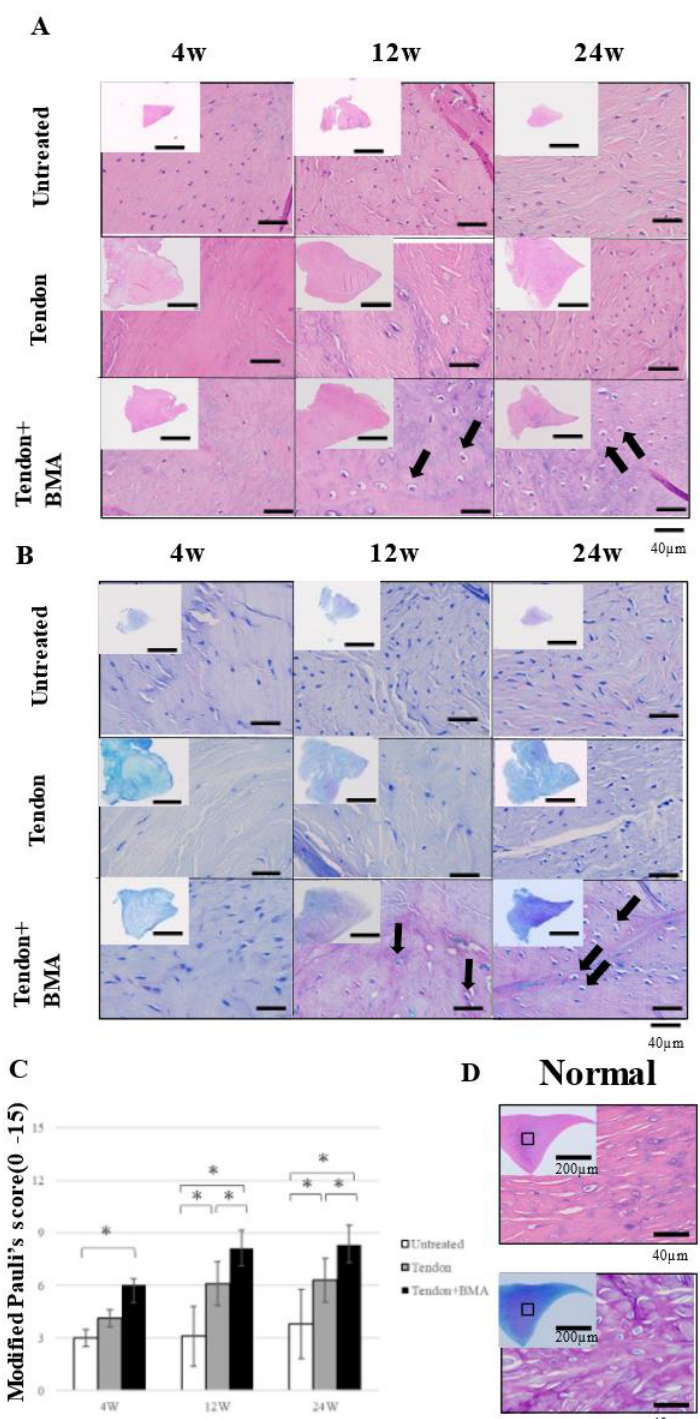
Figure 3. Hematoxylin and eosin (H&E) staining, toluidine blue staining, and modified Pauli’s scoring of the native meniscus and regenerated meniscus at 4, 12, and 24 weeks postoperative of three groups. ( A ) H&E staining of the regenerated meniscus revealed oval- or round-shaped fibrochondrocytes in the center of the regenerated meniscus in the tendon + BMA group. (black arrows). ( B ) Toluidine blue staining revealed metachromasia in the tendon + BMA group at 12 and 24 weeks postoperatively (black arrows). ( C ) Modified Pauli’s scoring; the tendon + BMA group had greater regeneration than the untreated and tendon groups at 12 and 24 weeks postoperatively ( n = 6, * p < 0.05). ( D ) H&E staining and toluidine blue staining of the native meniscus.